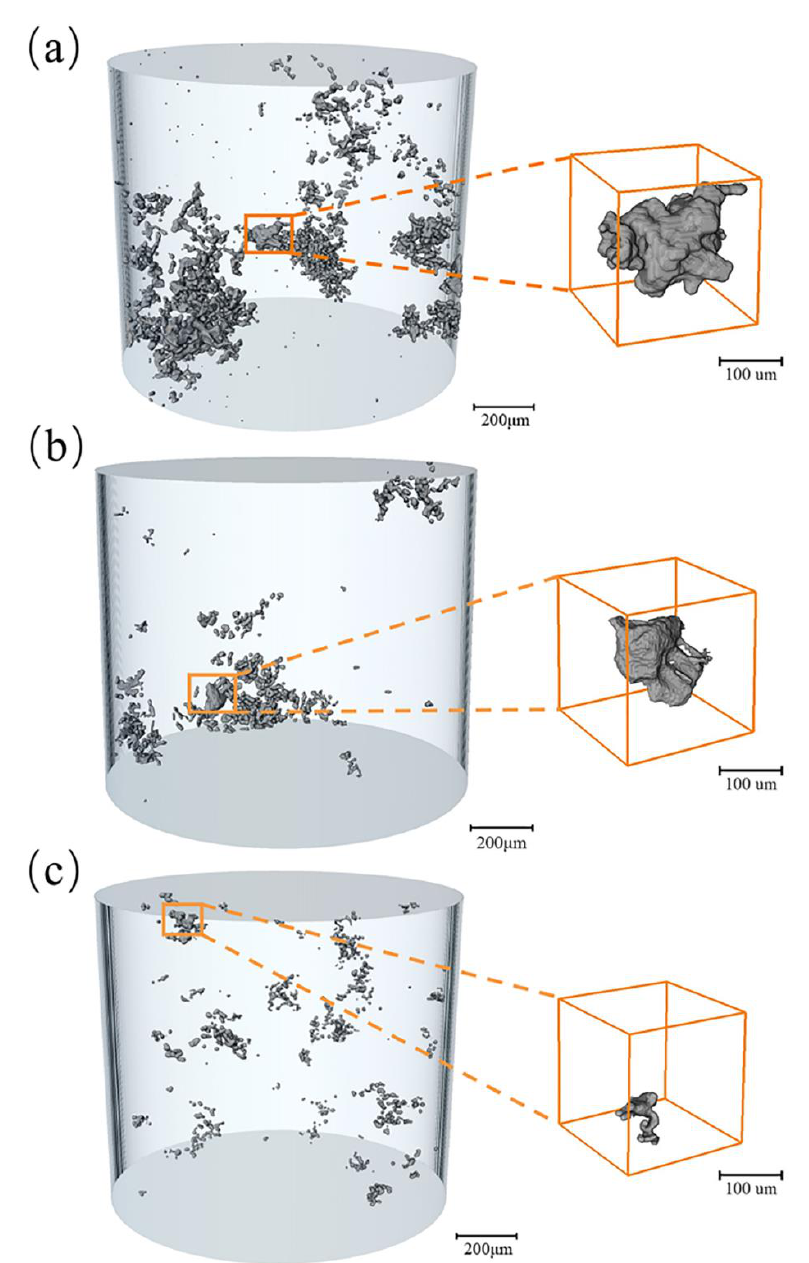
Figure 11. Typical pore morphology in ( a ) base ( b ) AlTiB ( c ) AlTiB + 0.1La and the corresponding largest size.